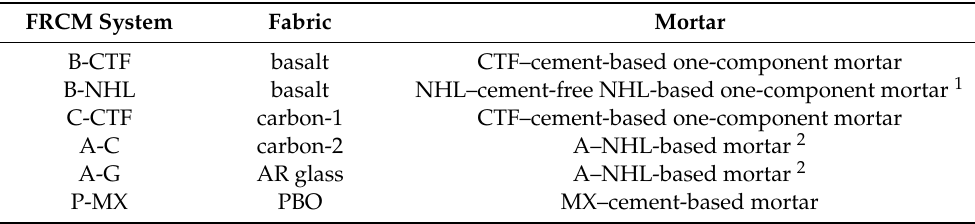
Table 1. FRCM systems used in experimental tests.